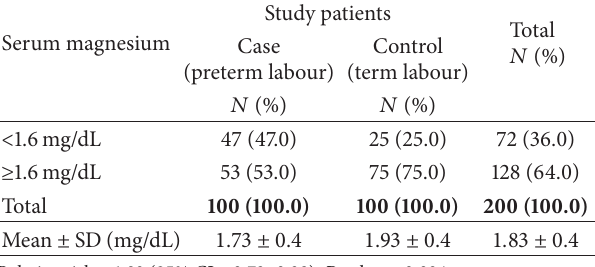
Table 3: Relationship between serum magnesium and preterm